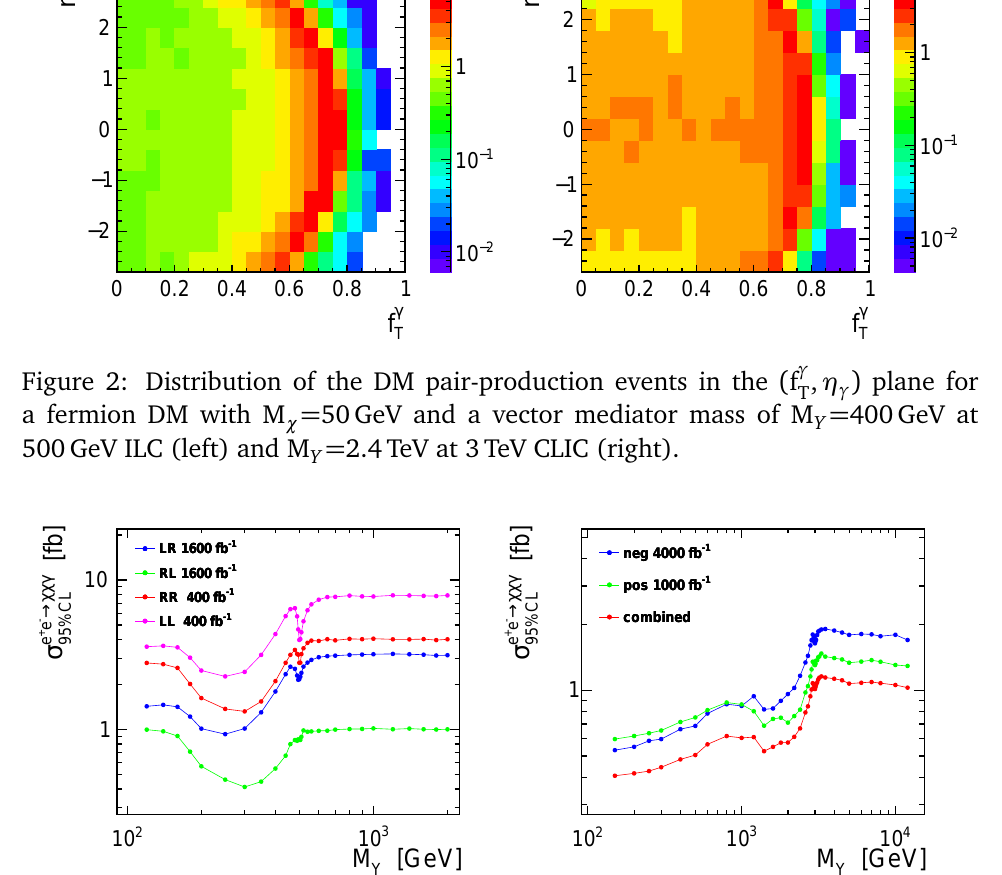
Figure 3: Limits on the radiative DM pair-production cross section for processes with the vector mediator exchange, for different beam polarisations, at 500 GeV ILC (left) and 3 TeV CLIC